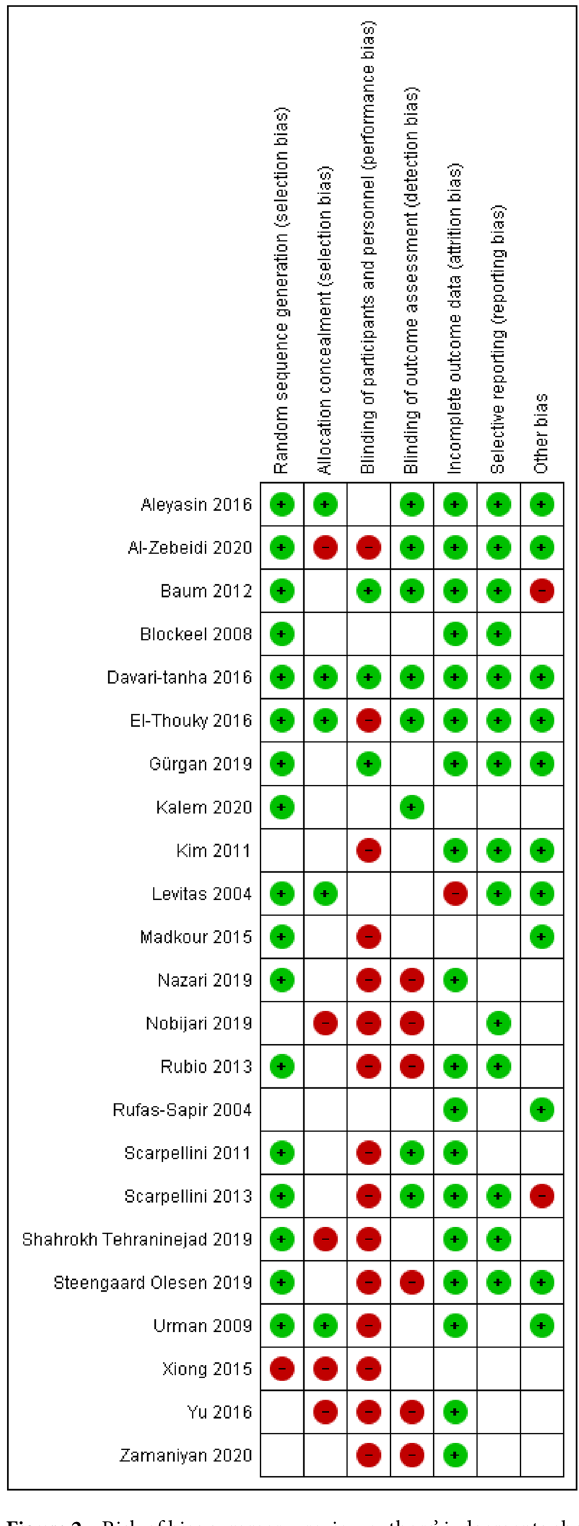
Figure 2. Risk of bias summary: review authors’ judgements about each risk of bias item for each included randomized controlled trial